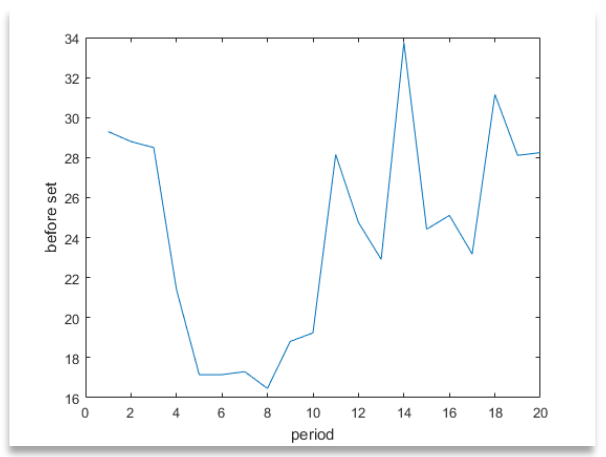
Figure 13. Graphs were drawn for pre-adjusted potential difference data for 20 time periods.